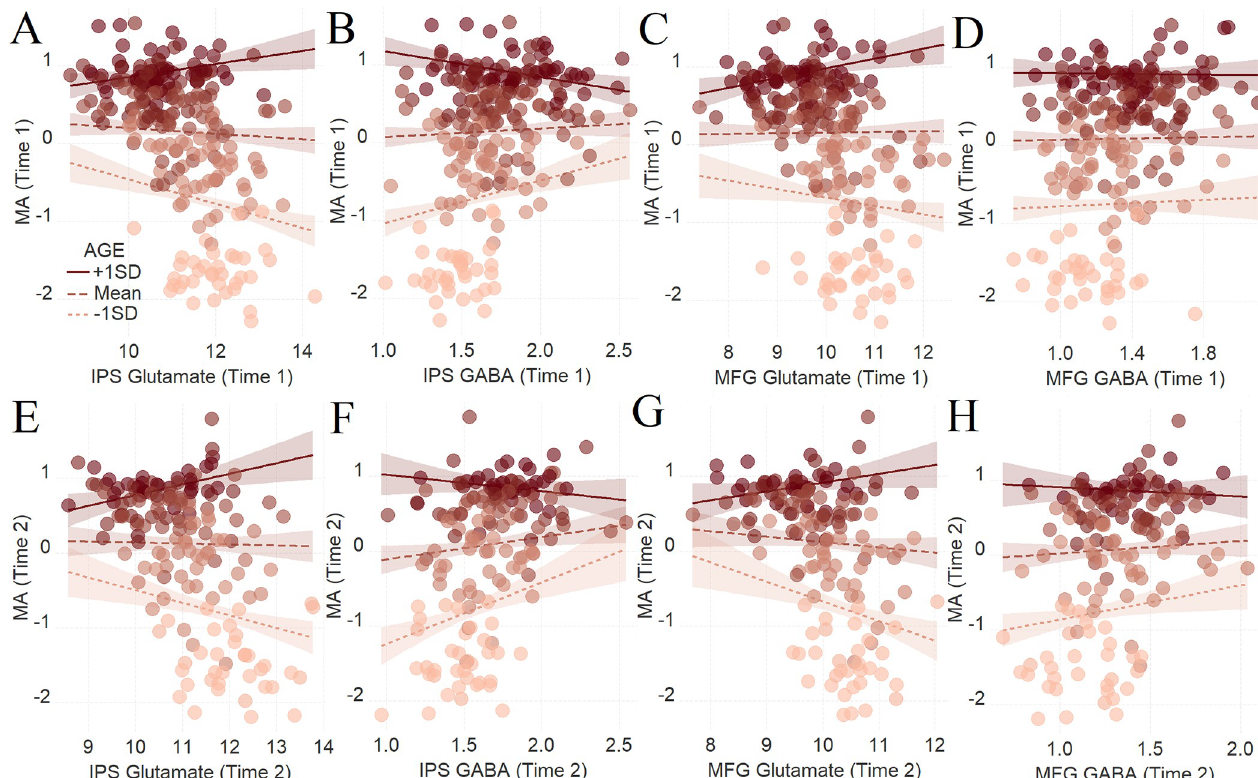
Fig 2. The moderating role of age in the relation between neurotransmitter concentration and MA at Time 1 (A–D) and at Time 2 (E–H). To depict the interaction between the continuous variables (age and neurotransmitter concentration), we plotted the regression lines for ± 1 SD from the mean age [53]. Dark color concerns +1 SD above the mean, while light color concerns − 1 SD below the mean. The average color represents the mean. ( A) Glutamate � age and (B) GABA � age in the left IPS at Time 1. (C) Glutamate � age and (D) GABA � age in the left MFG at Time 1. (E) Glutamate � age and (F) GABA � age in the left IPS at Time 2. (G) Glutamate � age and (H) GABA � age in the left MFG at Time 2. The shaded area represents 95% confidence intervals. The data underlying this figure can be found in S2 Data. GABA, gamma-aminobutyric acid; IPS, intraparietal sulcus; MA, mathematical achievement; MFG, middle frontal gyrus; SD, standard